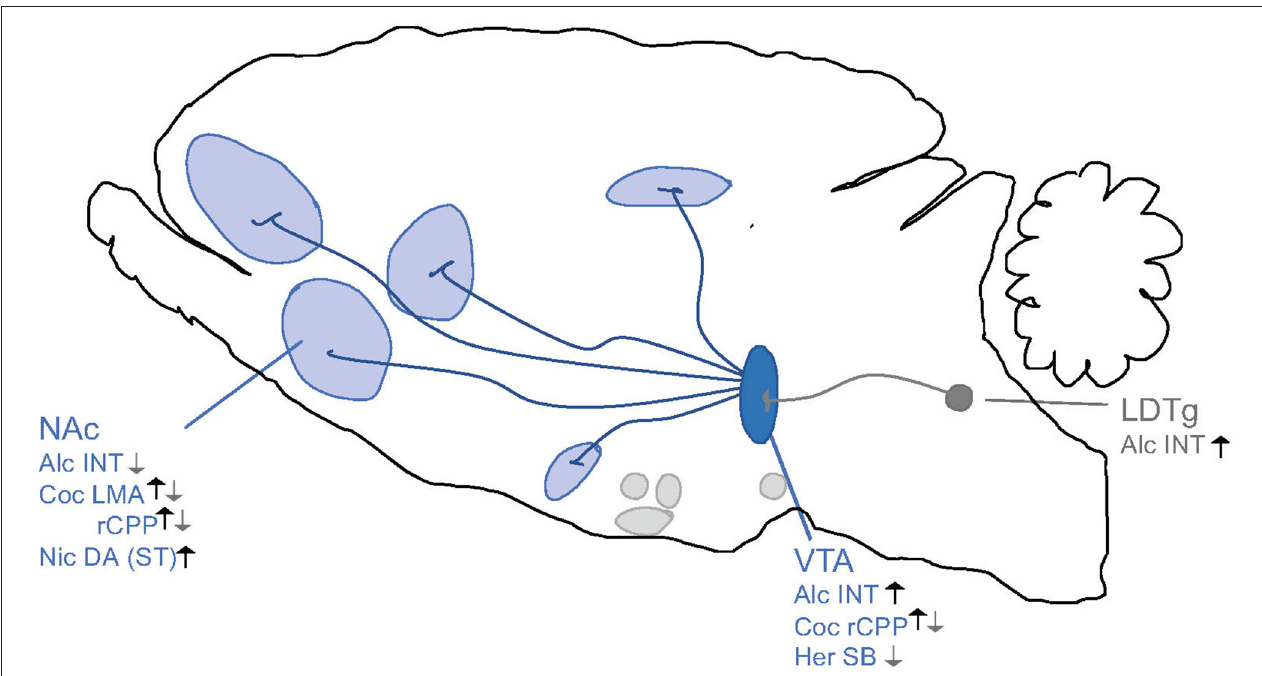
FIGURE 8 | Schematic illustrations of brain regions important for the interaction between the ghrelin pathway and addiction processes. Ghrelin enhances (black arrows) whereas GHSR-1A antagonists (gray arrows) attenuates behaviors of alcohol (Alc), nicotine (Nic), cocaine (Coc) and heroin (Her) like locomotor stimulation (LMA), reward of conditioned place preference (rCPP), dopamine release in NAc shell (DA), alcohol or drug intake (INT) and seeking behaviors (SB) via areas above. Ventral tegmental area (VTA), nucleus accumbens (NAc), striatum (ST), laterodorsal tegmental area (LDTg). Increases/Enhances ( ↑ ), decreases/attenuates ( ↓ ), conflicting evidence or no effect ( ∅ ) on drug